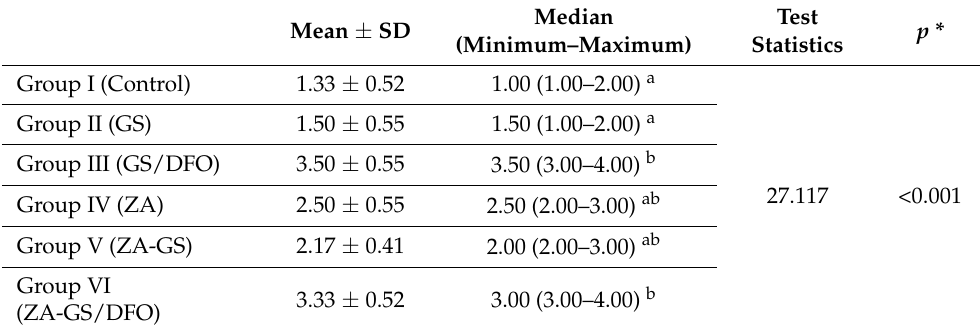
Table 4. Comparison of the intensity levels of HIF-1 α expression in the extraction